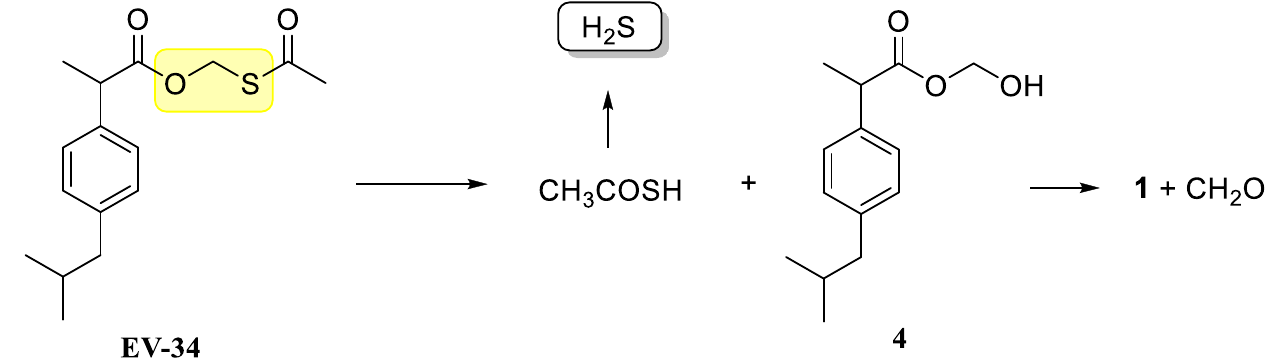
Figure 4. Possible reaction pathways for the release of H 2 S from EV-34.